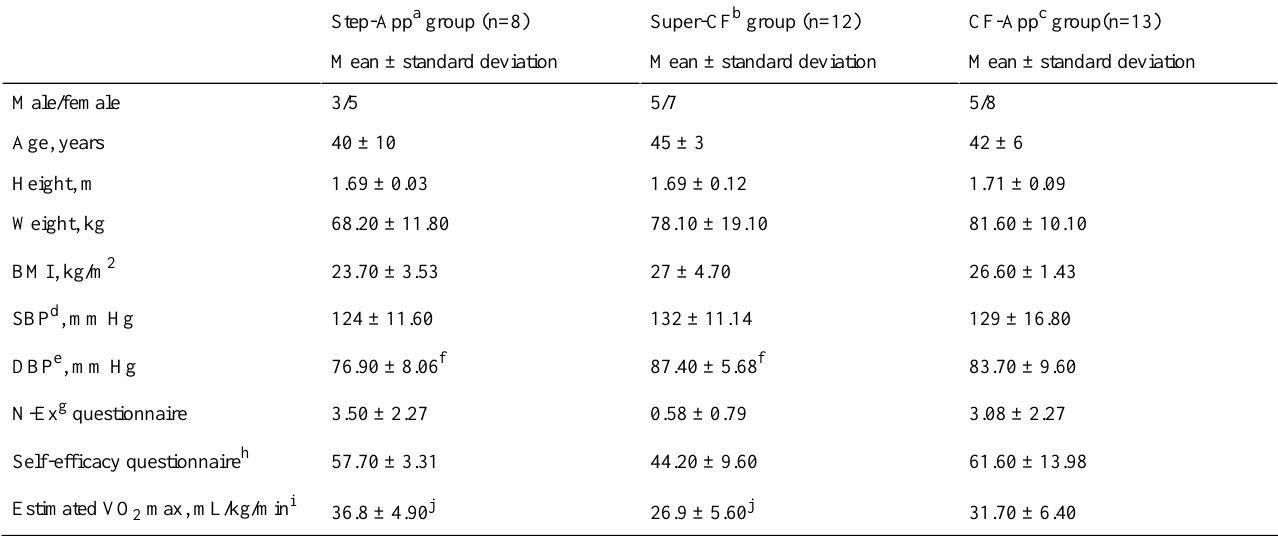
Table 1. Participant